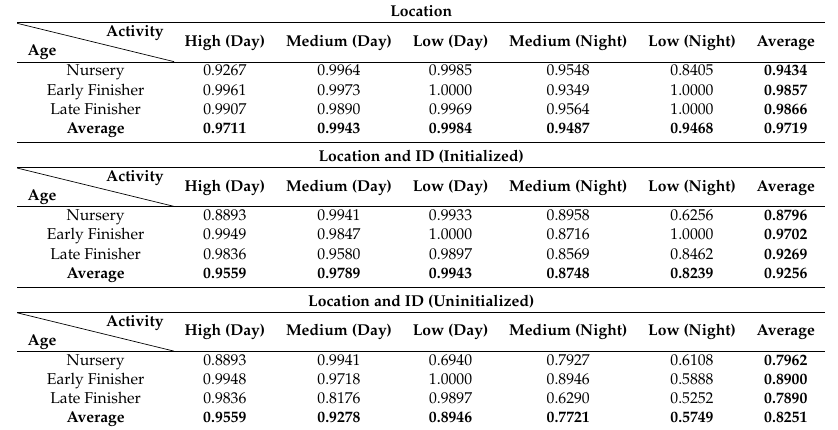
Table 2. Precision/recall results for all 15 videos in the human-annotated dataset. The precision/recall results in “Location” do not require the tracker to provide the correct ID for animals. Instead, it is only required that each animal’s location is matched with a detection. The “Location and ID” results require the tracker to correctly identify the location and correct ID of a pig in order to be counted as a true positive. The “(Uninitialized)” variant does not provide the location and ID of each pig in the first frame, whereas the “(Initialized)” variant